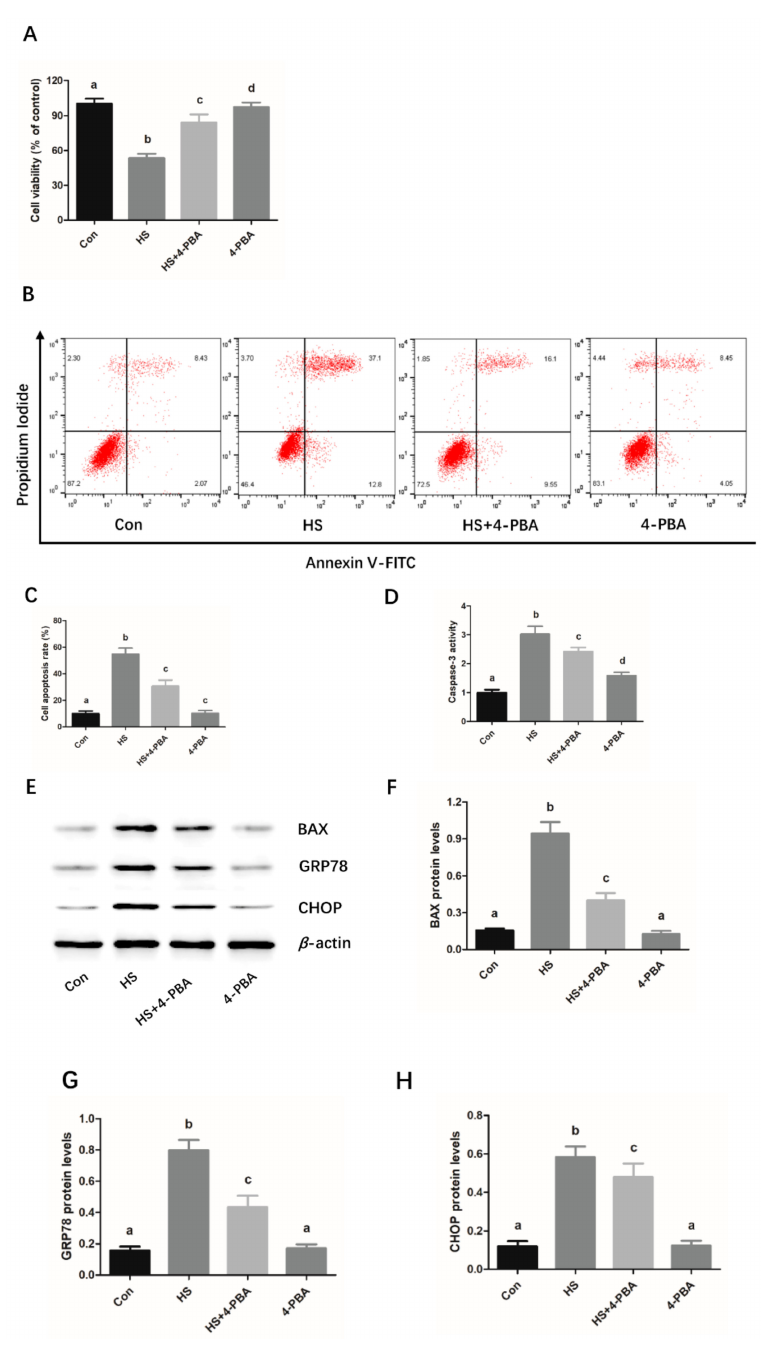
Figure 3. 4-PBA attenuates the heat stress-induced apoptosis and ER stress in mouse granulosa cells. Cells were treated with or without 4-PBA (500 nM) at 39 ◦ C for 24 h, and then harvested for analyzing the cell viability and apoptotic rate by CCK-8 assay ( A ) and flow cytometry ( B , C ), respectively. Caspase 3 Activity of the mouse granulosa cells was analyzed by a colorimetric assay kit ( D ). Western blot analysis of the expression of BAX, GRP78, and CHOP are shown ( E ). The relative protein expression levels of BAX ( F ), GRP78 ( G ) and CHOP ( H ) were normalized to β -actin. The statistical analysis results are shown as bar graphs. The data are represented as the mean ± SEM of three independent experiments, and each independent experiment includes three technical replicates. Bars with di ff erent lowercase letters are significantly di ff erent ( p <